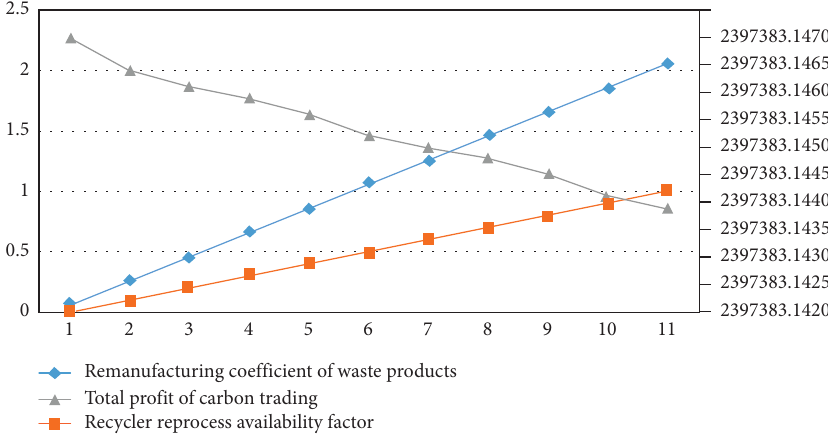
Figure 5: Change of total profit of carbon trading with the remanufacturing coefficient μ of waste products.